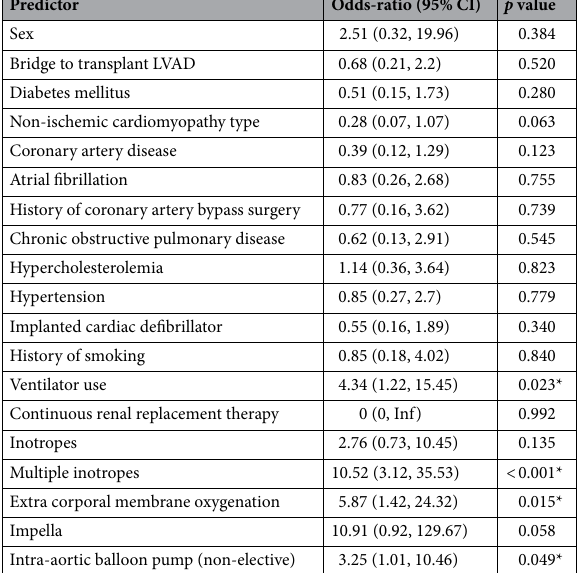
Table 3. Odds-ratios of each binary risk factor for early right heart failure based on univariate logistic regression models.